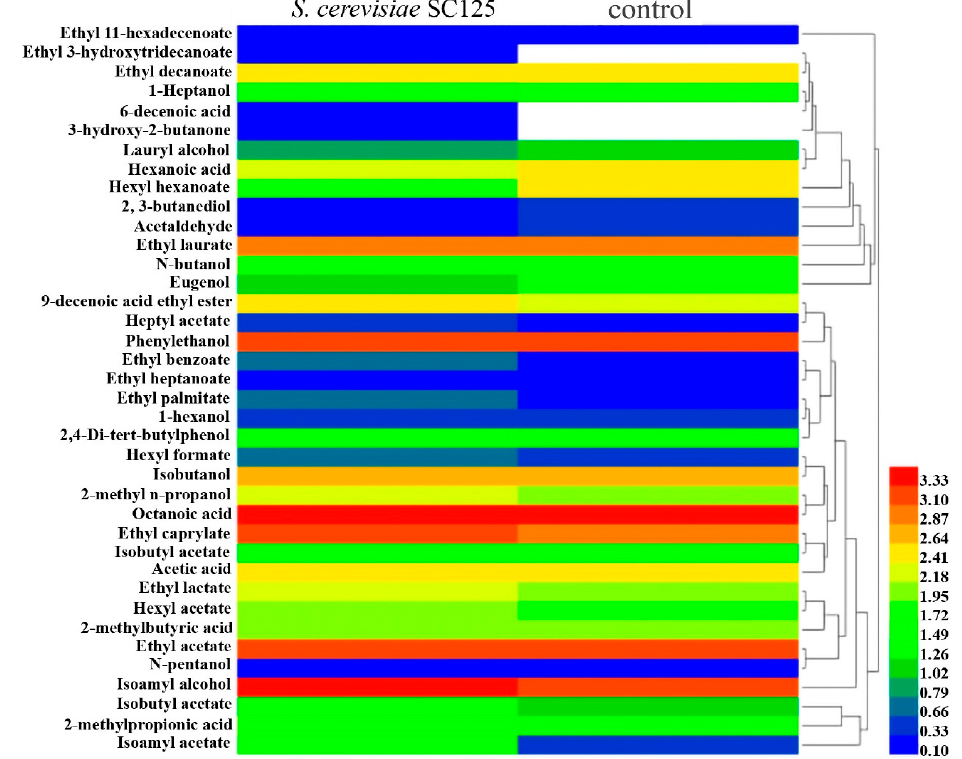
Figure 4. Heatmap of volatile compounds in fermented apple beverages. Different colors indicate different volatile compound content levels. The legend indicates the contents levels from the bottom to the top, where blue colors indicate lower content levels and red colors indicate higher content levels.